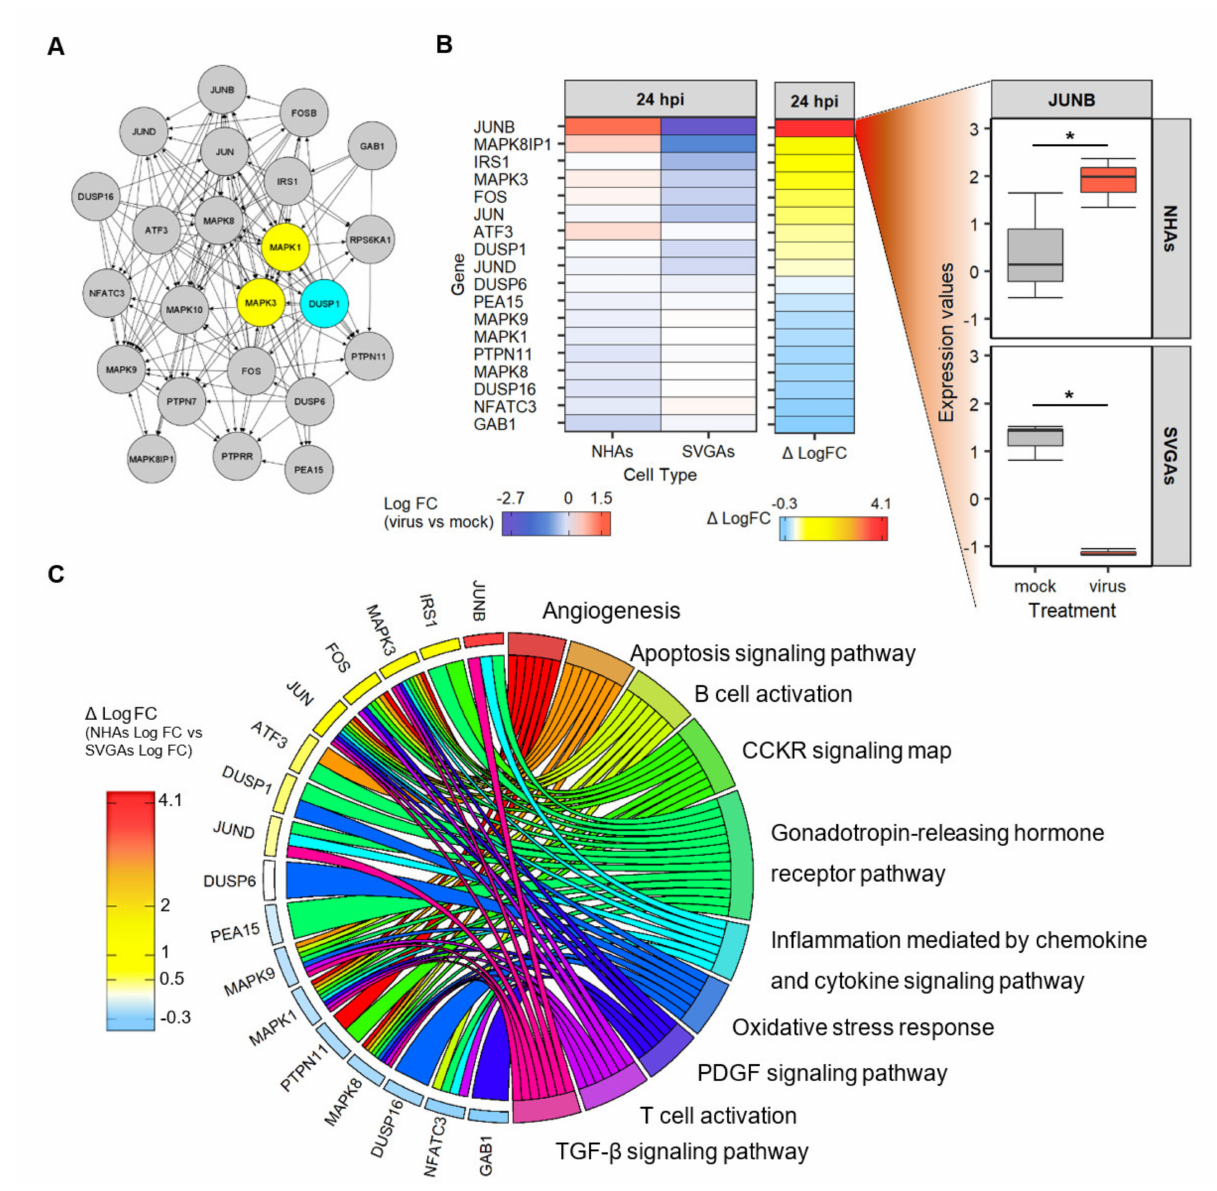
Figure 6. PANTHER pathway analysis of the genes within the DUSP1–ERK1/2 network, specifically JUNB, reveals pathways in immune activation and downstream activation of the receptor tyrosine kinase pathways. ( A ) Genes ERK1/2 and DUSP1 were analyzed in the STRING interaction database and the network was expanded three times to determine the protein–protein interactions of both known and predicted interactions of the surrounding genes. These interactions were defined as having an interaction score of 0.4 with no more than 10 interactors in the 1st and 2nd shell. Arrows point from the source gene to the target gene. ( B ) The heat map illustrates the log 2 fold change of JCPyV-infected versus mock-infected NHAs and SVGAs for all genes and the ∆ log 2 fold change between cell types from the previous network that were differentially expressed at 24 h. The expression values (log CPM) of JUNB were determined, illustrated by box and whisker plots with the distribution of 3 samples, with the median denoted by the black line and whiskers representing values 1.5 times the distance of the inter-quartile range. *, p < 0.05. ( C ) PANTHER pathway analysis was used to identify the pathways from the genes in the ERK1/2 and DUSP1 network. A GOChord plot represents the top ten pathways, representing at least 35% of the 17 genes in the network. Each gene is linked via ribbons to their assigned PANTHER pathway term and the colored bars next to each gene represent the difference between the log 2 fold change in JCPyV-infected versus mock-infected NHAs and between JCPyV-infected versus mock-infected SVGAs. The gene, MAPK8IP1 was not included in the PANTHER pathway analysis as it is not in the PANTHER pathway